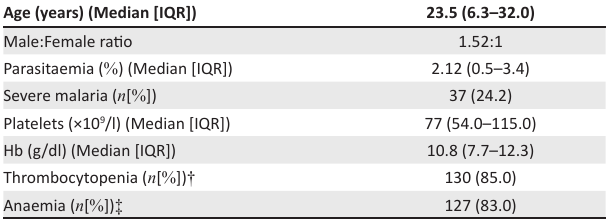
TABLE 2: Pertinent demographic